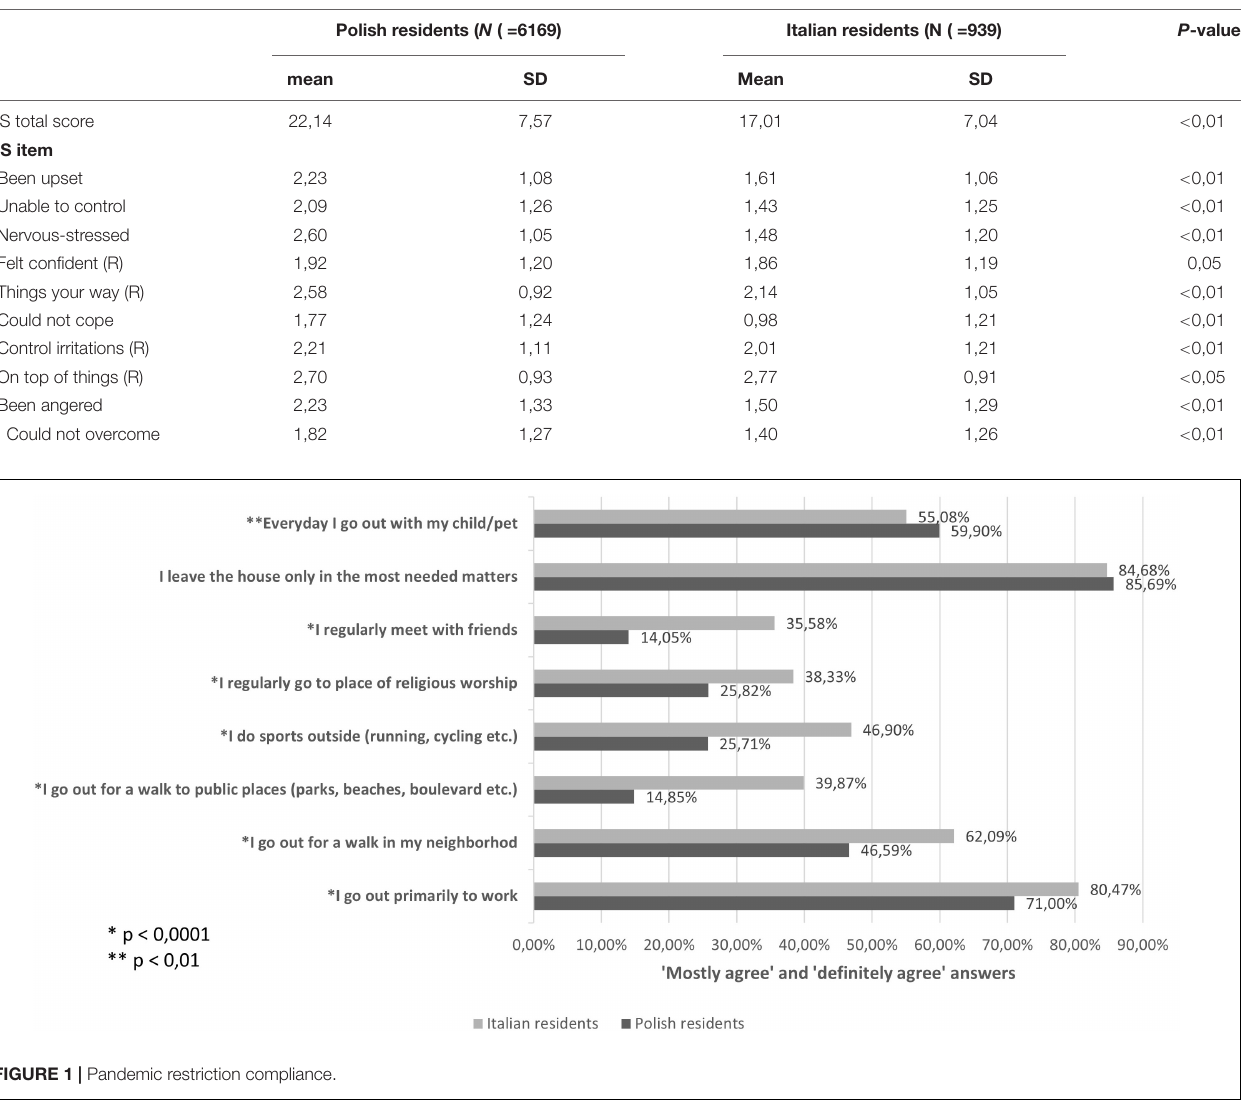
number of respondents admitted to having been diagnosed with COVID-19 (0.21% in the whole study group), having respiratory tract infection symptoms (6.02%), or having a close relative with current respiratory tract infection (6.14%), while 1.87% of the subjects confirmed the COVID-19 infection in their